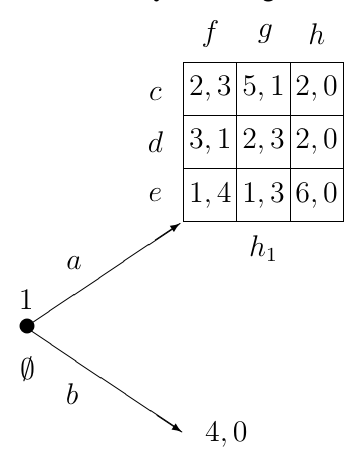
Figure 3. Rationality